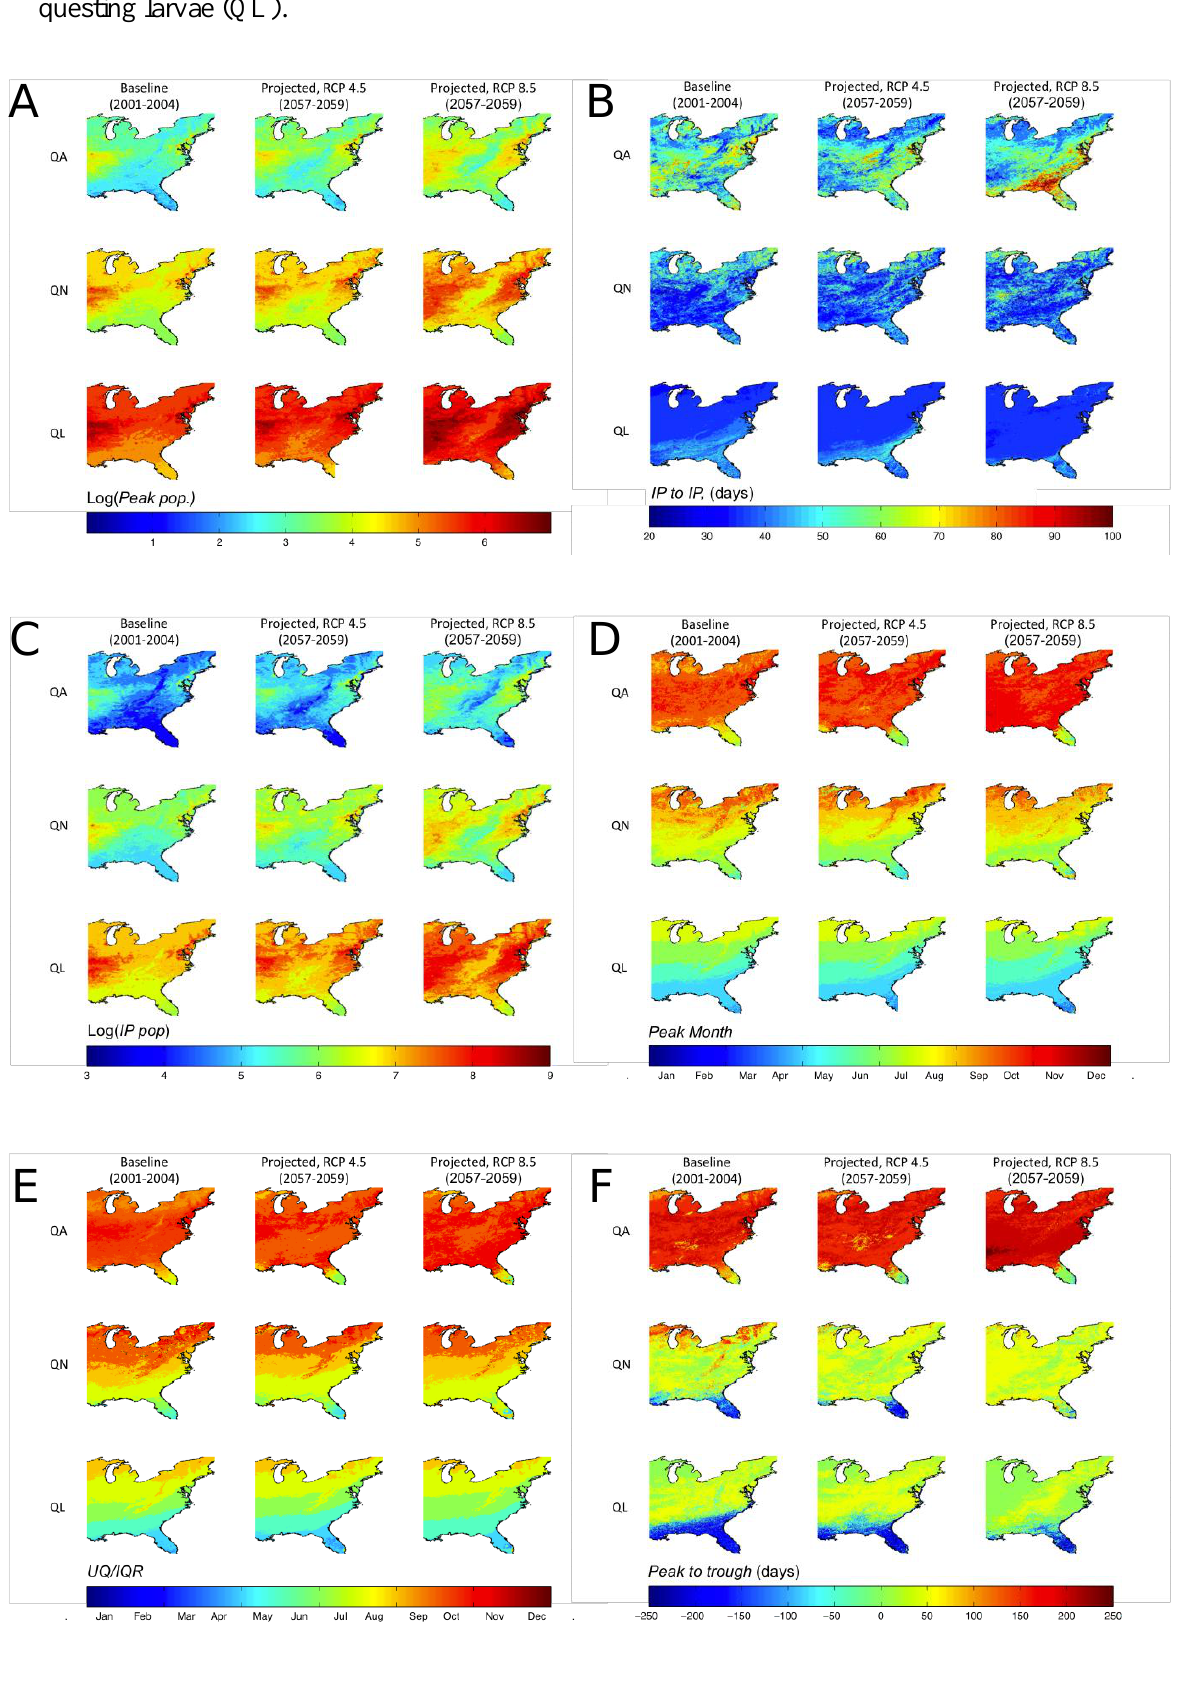
Figure 1. ( A ) Log of Peak Population , ( B ) IP to IP , ( C ) log of IP Pop , ( D ) Peak Month , ( E ) UQ/IQR and ( F ) Peak to Trough for questing adults (QA), questing nymphs (QN) and questing larvae